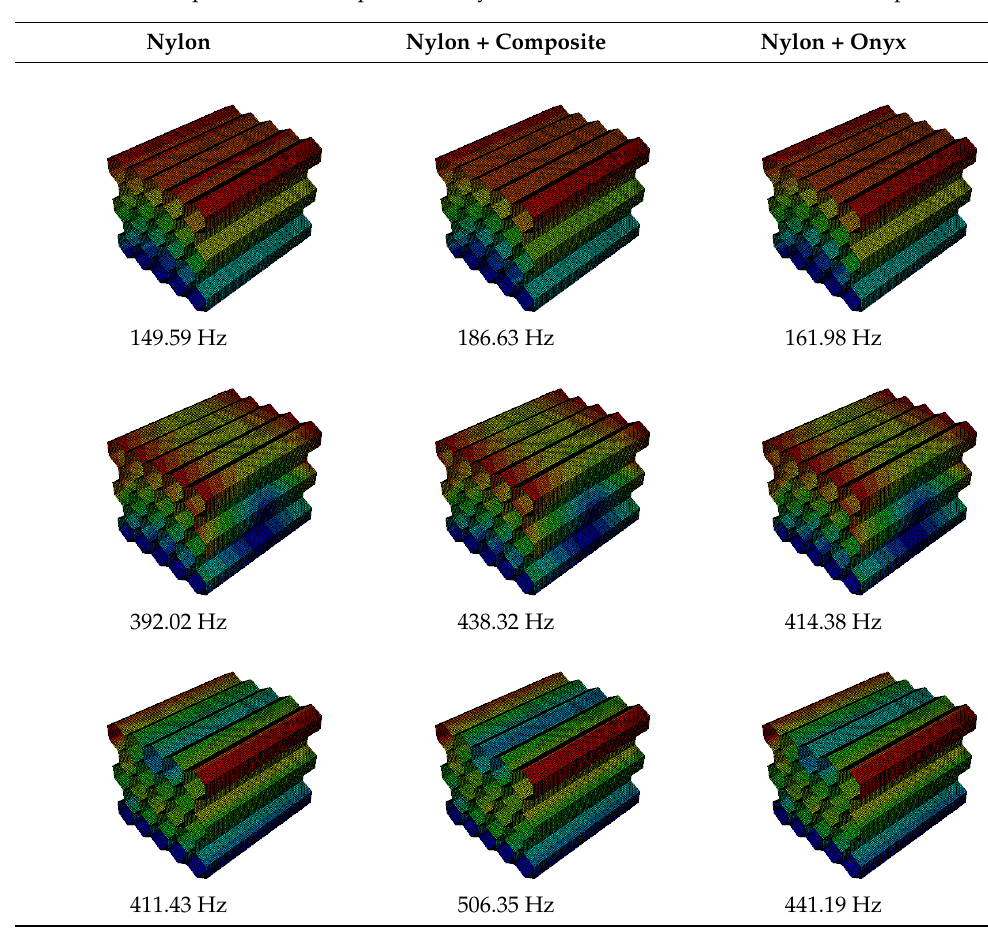
Table 6. First five paired mode shapes of Honeycomb Lattice Structure with bottom